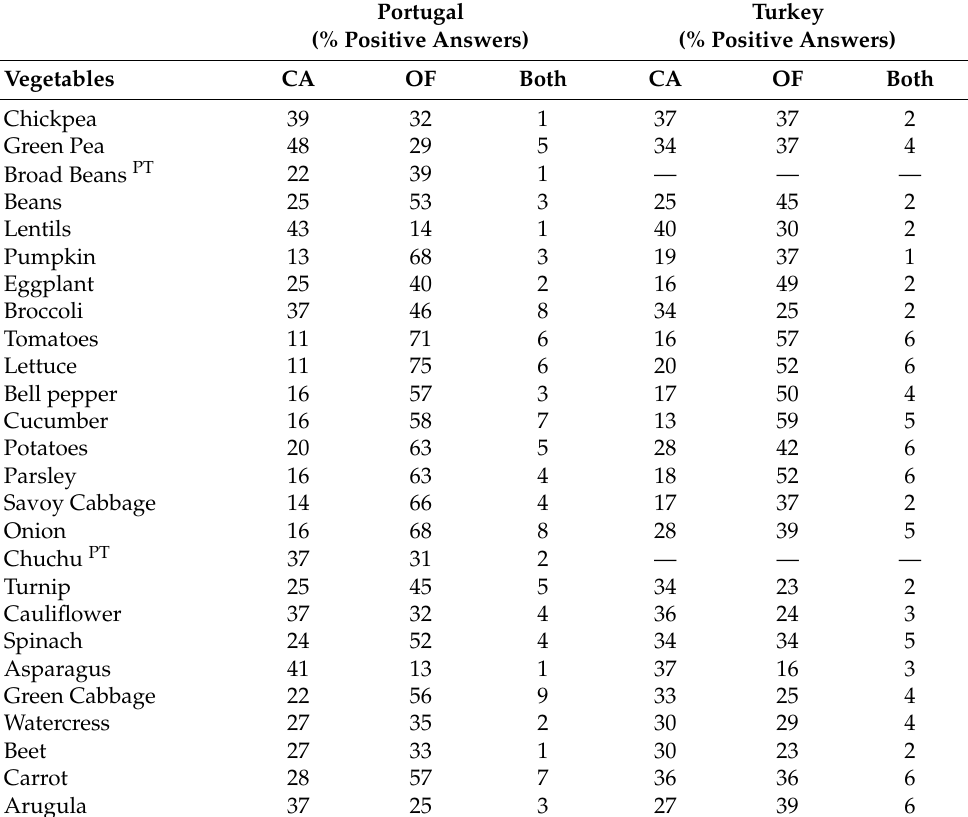
Table 2. Consumption of food from organic and conventional production, according to categories.